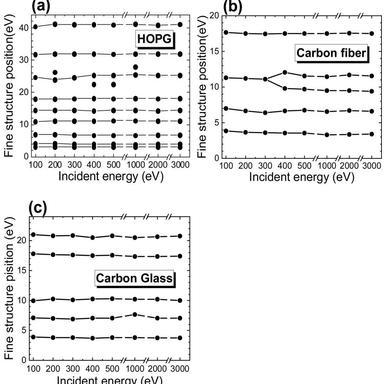
Comparison on the fine structure positions of the negative second-order differential SES spectra at different incident energies between (a) HOPG, (b) carbon fiber and (c) carbon glass.